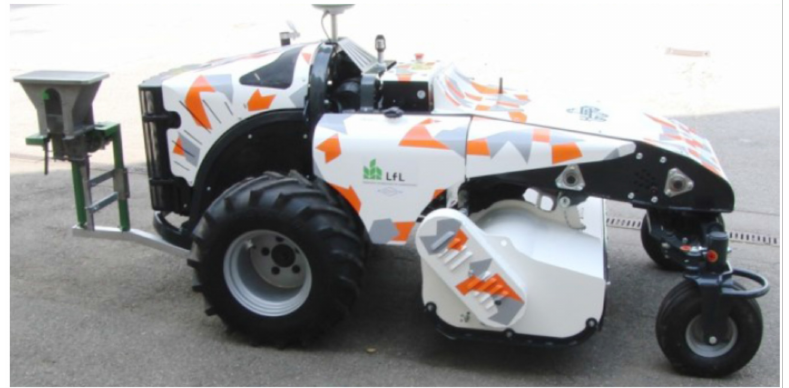
Figure 7. Pasture robot system concept proposed by Gobor et al. [108] incorporating mulcher and